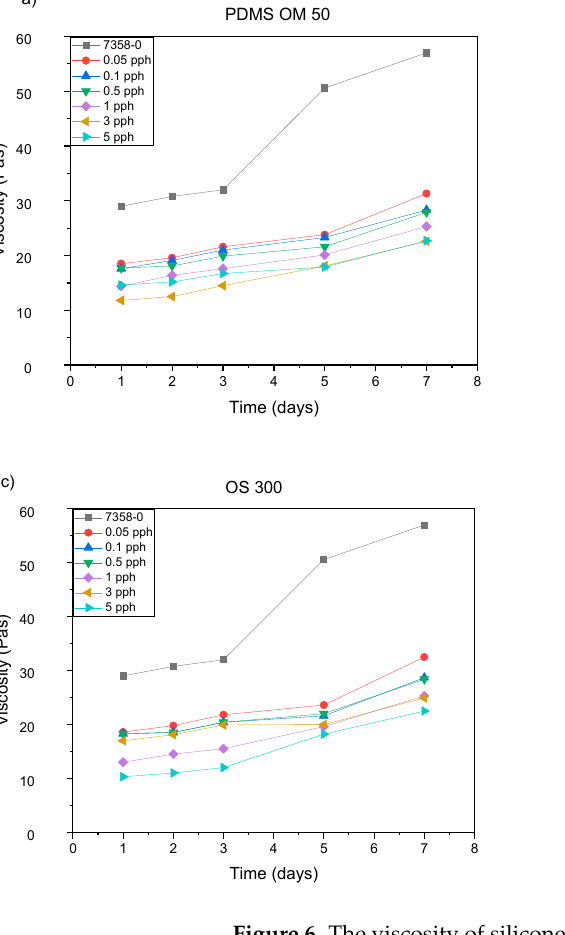
Figure 6. The viscosity of silicone pressure sensitive adhesives depending on the ingredient added: ( a ) PDMS OM 50, ( b ) PDMS 500, ( c ) OS 300, ( d ) SILOL350F.